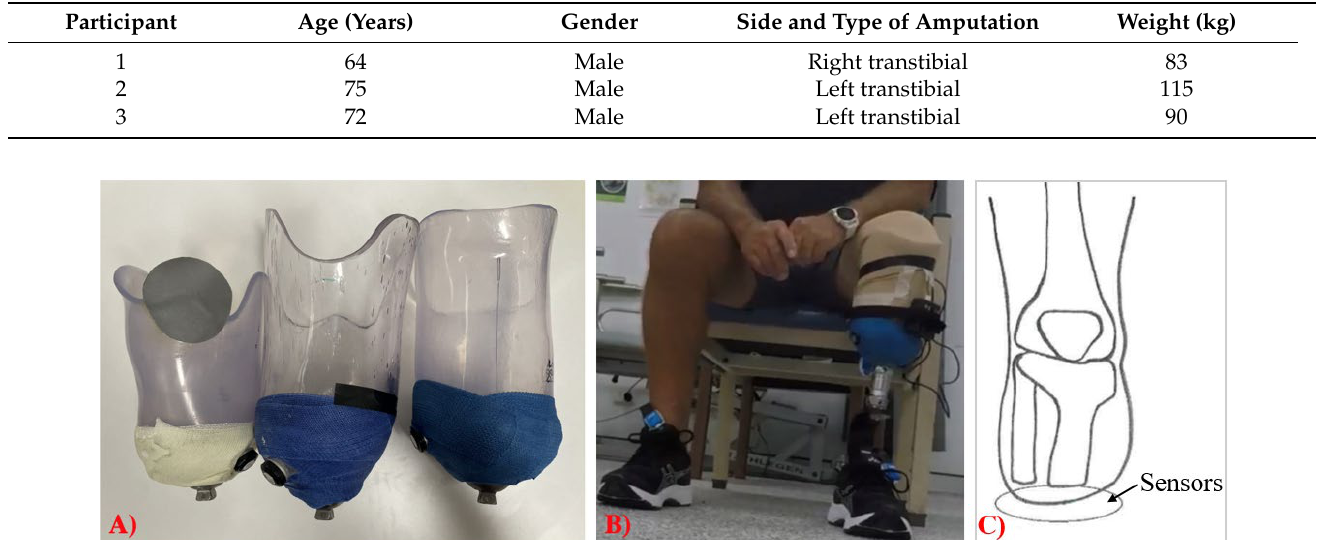
Figure 7. Experimental setup: ( A ) participants’ check sockets, ( B ) participant wearing the sensor system , ( C ) sensor placement on the distal end of a residual limb, where one SingleTact and one Loadpad force sensor were placed .